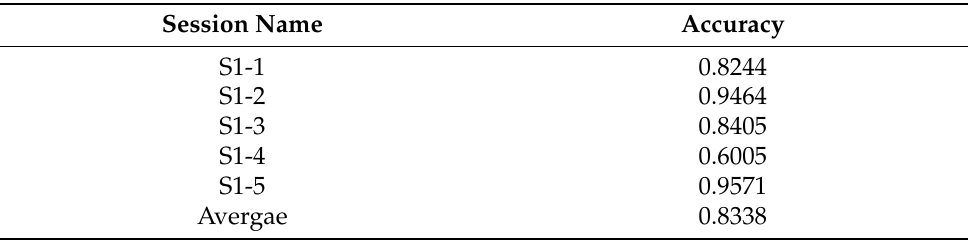
Table 4. The prediction performance of the proposed method on the same subject. Four out of five sessions had a prediction accuracy grater than